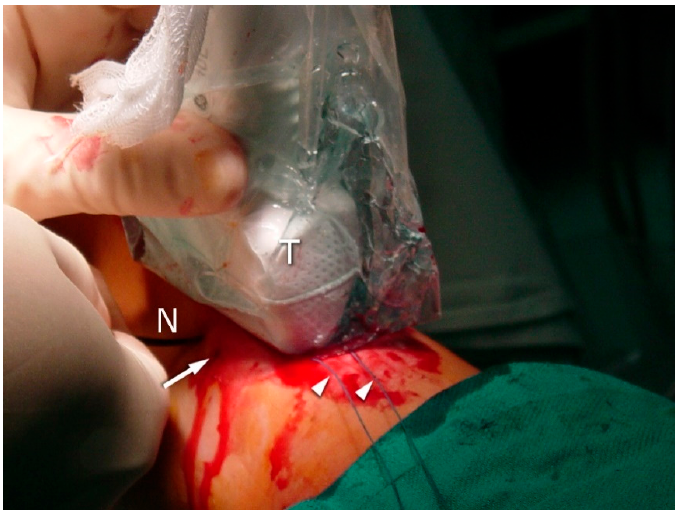
Figure 3. The needle: the second stage of the surgery; distal sutures are performed by placing the needle (N) distally under the transducer (T) control. Note the puncture (arrow) resulting from the first suture (arrowhead).